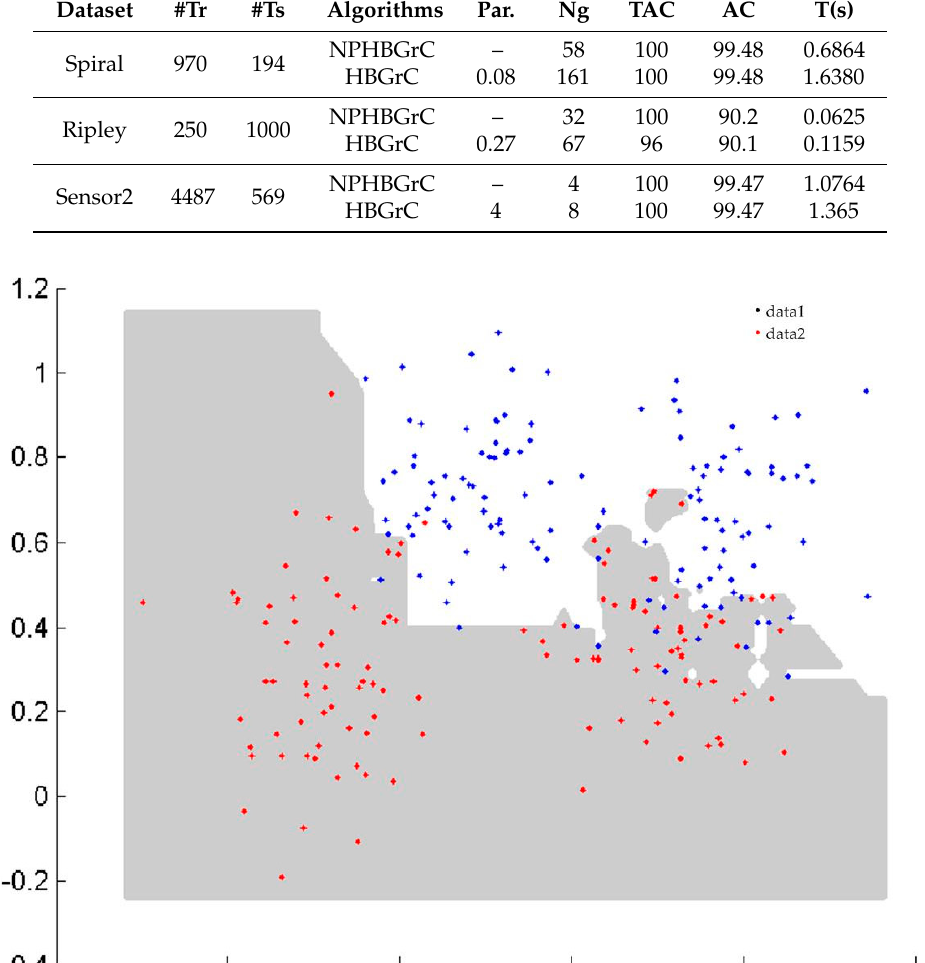
Table 1. The classification problems and their performances in 2-D space.